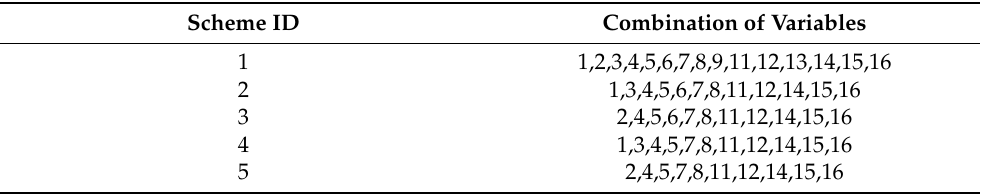
Table 5. Variable combination schemes for the CNN-LSTM model